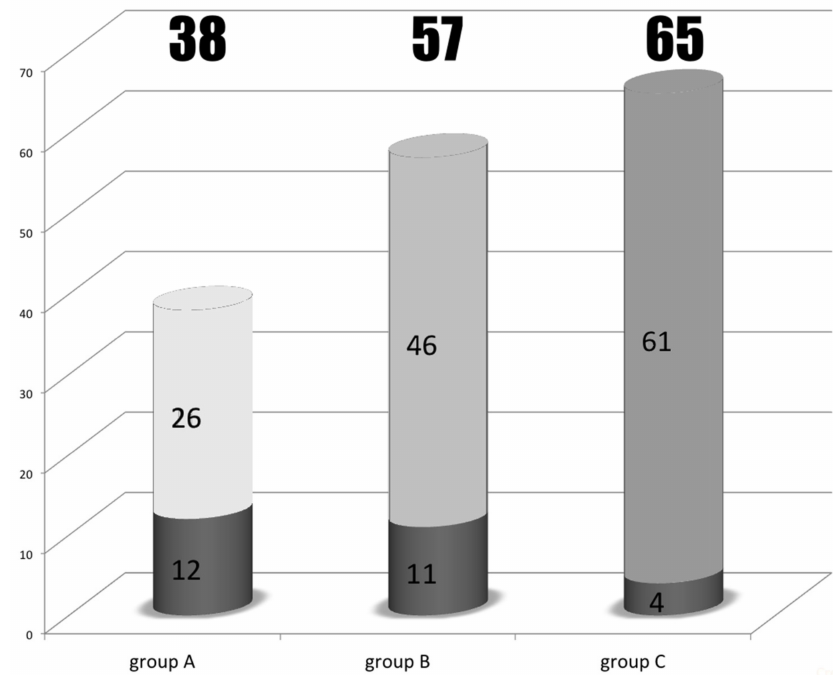
Figure 5. The individual number of patients who underwent a second operation within each group.